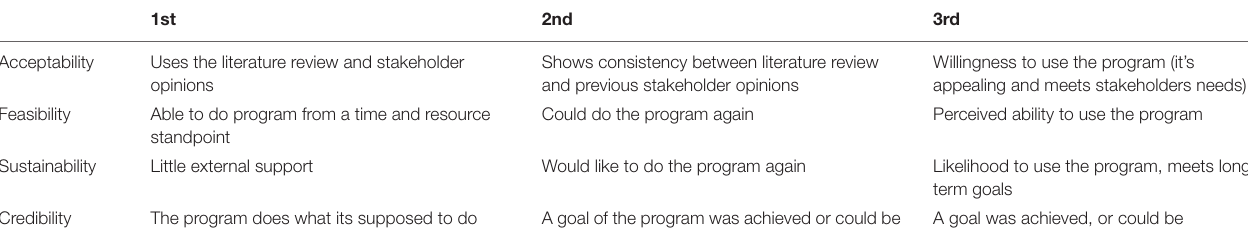
TABLE 2 | Definition table. 1st 2nd